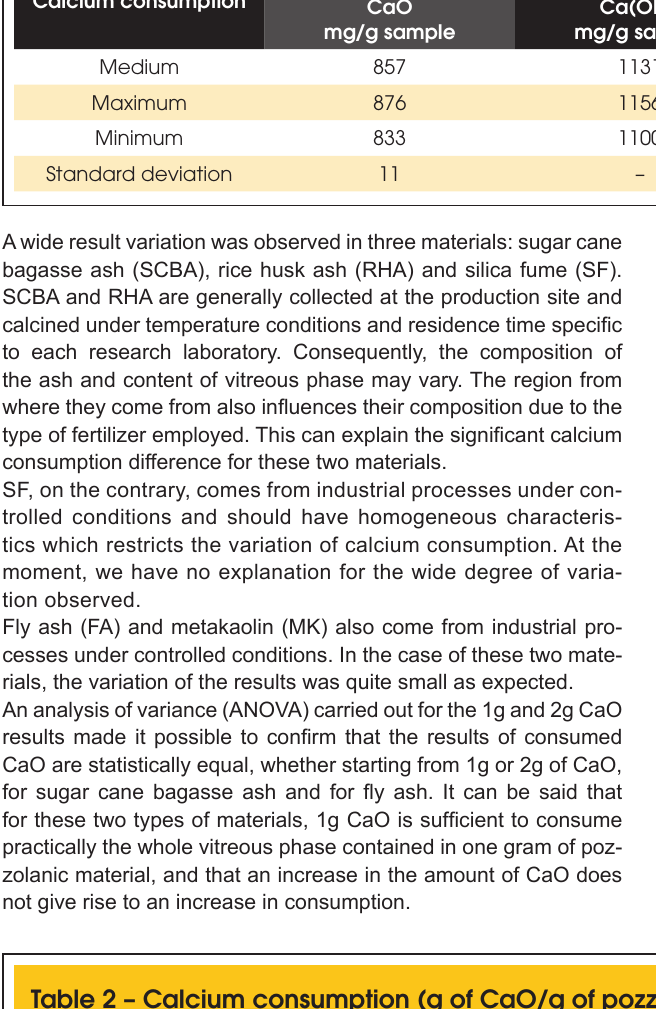
Table 2 – Calcium consumption (g of CaO/g of pozzolanic material) of different pozzolanic materials. Tests were carried out with 1g or 2g of CaO. SCBA = sugar cane bagasse ash; RHA = rice husk